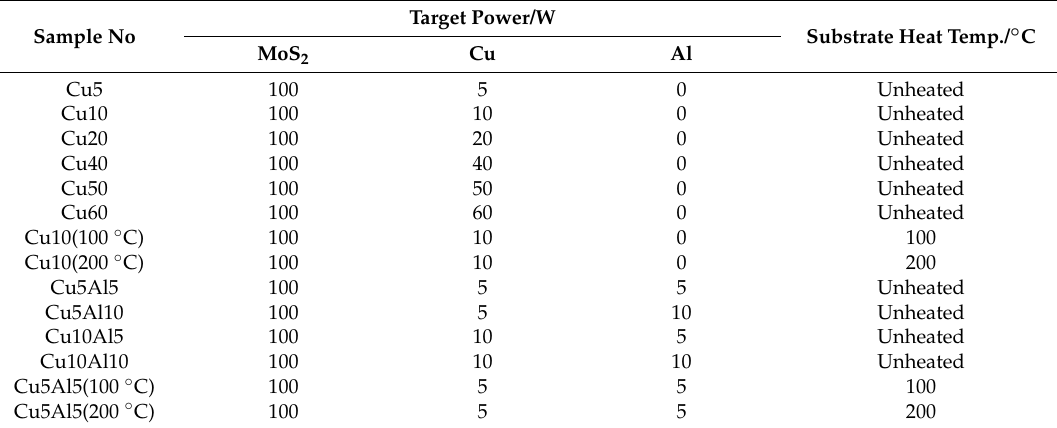
Table 1. Parameters for fabrication of MoS 2 -based composite